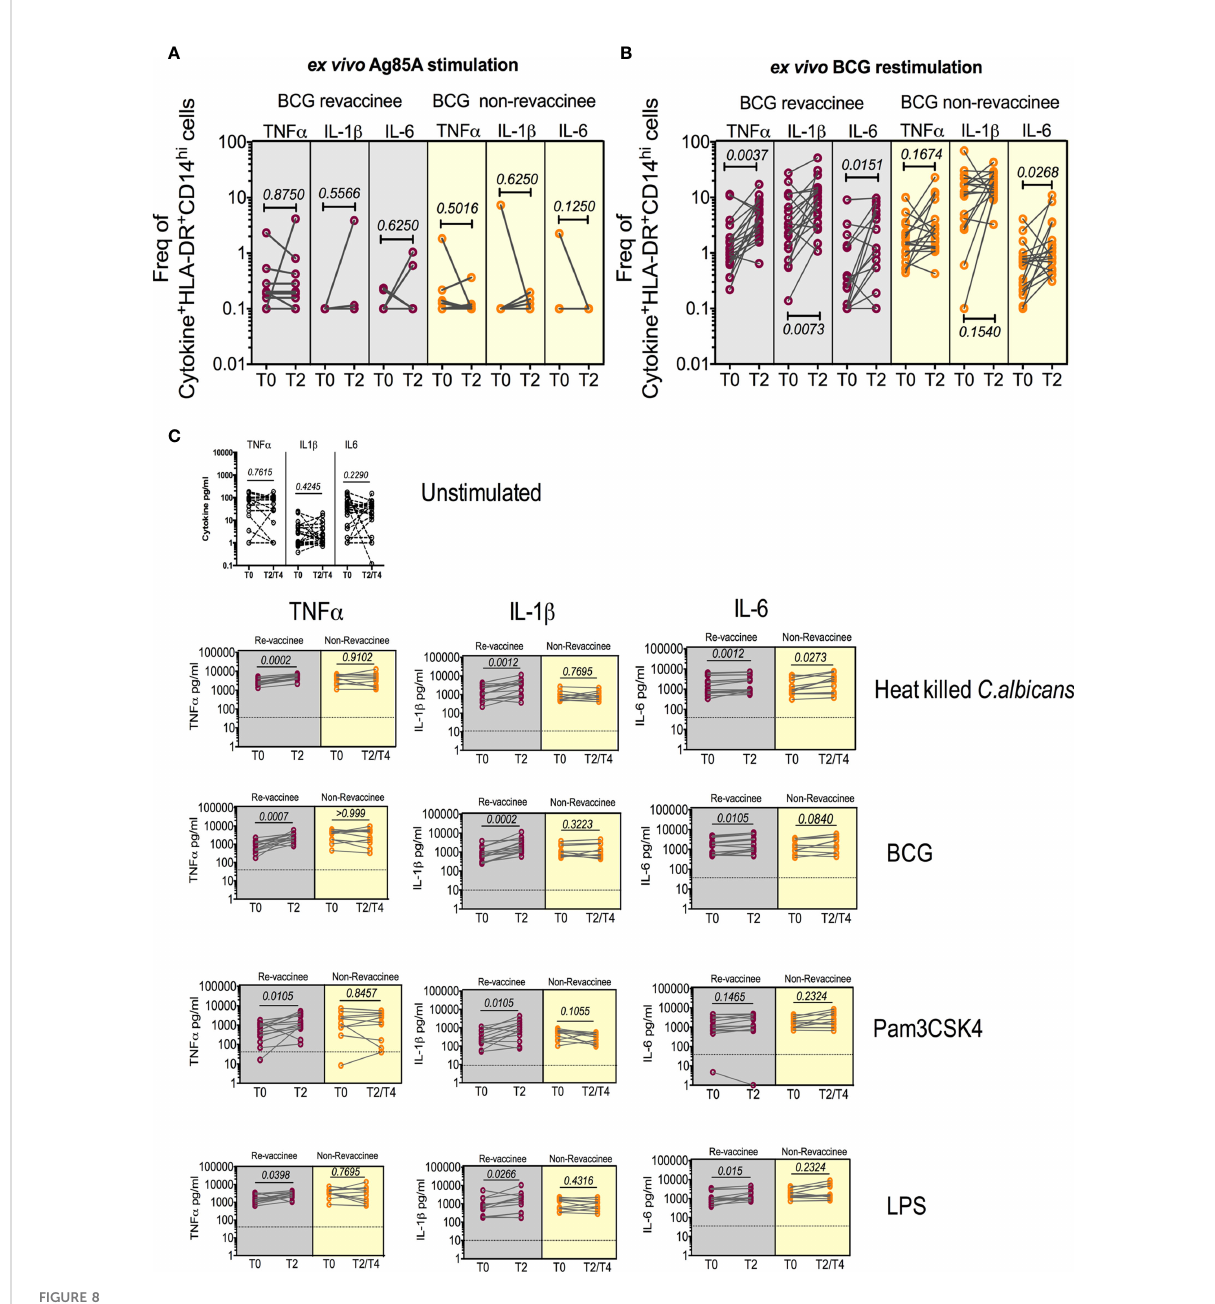
FIGURE 8 BCG revaccination boosts innate effector responses in HLA-DR+ monocytes and trained immunity effectors to PAMP stimulation. Whole blood from 20 BCG-RV and 18 BCG-NRV at baseline (T0) and 10-12 weeks (T2) post-revaccination was or stimulated with either Ag85A (A) or BCG (B) for 12hr following which samples were frozen. Frozen samples were thawed and stained to assess expression of innate effectors in the monocyte compartment. Frequencies of TNF- a +, IL-1 b + and IL-6+ monocytes after background subtraction were plotted for comparison of responses at T0 and T2. (C) PBMC from 13 BCG-RV and 10 BCG-NRV at baseline (T0), 10-12 weeks (T2) or 51-68 weeks (T4) post-re- vaccination were left unstimulated or stimulated with 10 6 cfu/ml C. albicans , 0.2x10 6 cfu/ml BCG, 1ng/ml LPS and 50 m g/ml Pam 3 CSK 4 for 24hr after which supernatants were harvested for ELISA of TNF- a , IL-1 b and IL-6. Absolute concentrations of secreted cytokines were read off a standard curve and plotted after subtraction of background. Cytokines secreted by unstimulated cells (i.e., background) are shown separately at the top of the fi gure. BCG-RV and BCG-NRV are depicted by grey and yellow shaded areas respectively. Statistical signi fi cance was determined by Wilcoxon signed-rank